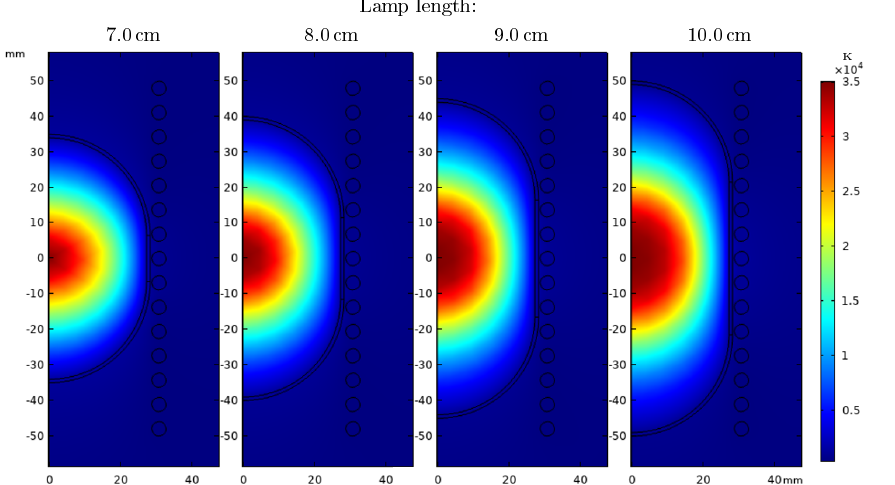
Figure 8. Comparison of plasma temperature distribution with different lamp lengths. Here, a coil with 15 windings was simulated to reproduce the real system for the